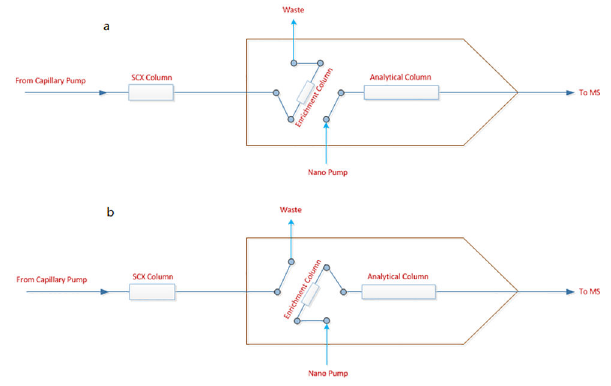
Figure 1. Workflow of on-line 2-D nano-LC. (a) The peptides eluted through SCX column and trapped onto enrichment column. (b) HPLC-chip was switched to analytical mode and the previously trapped peptides were eluted and analysed by analytical